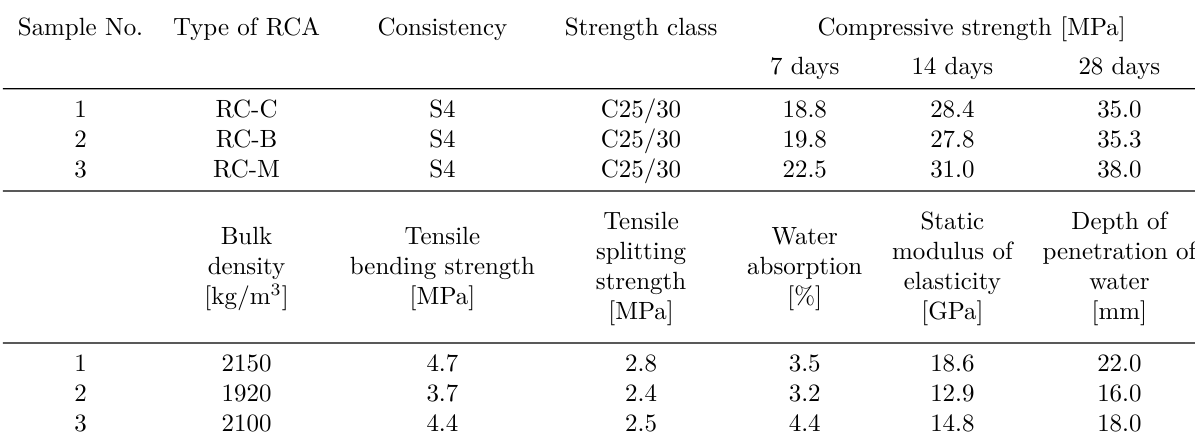
Table 1. Results of final laboratory tests during initial development.